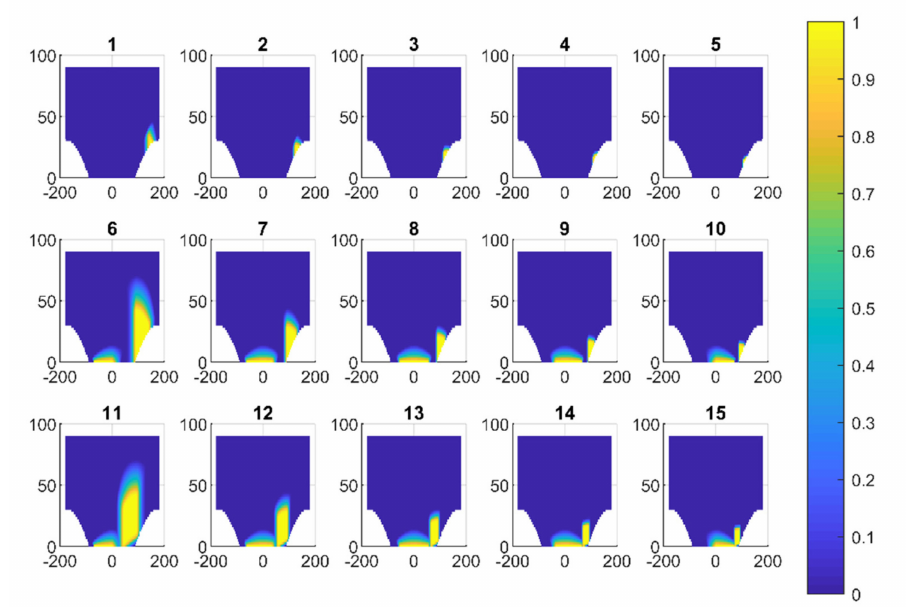
Figure 25. Shading tables for each of the modules in the array, represented as heat